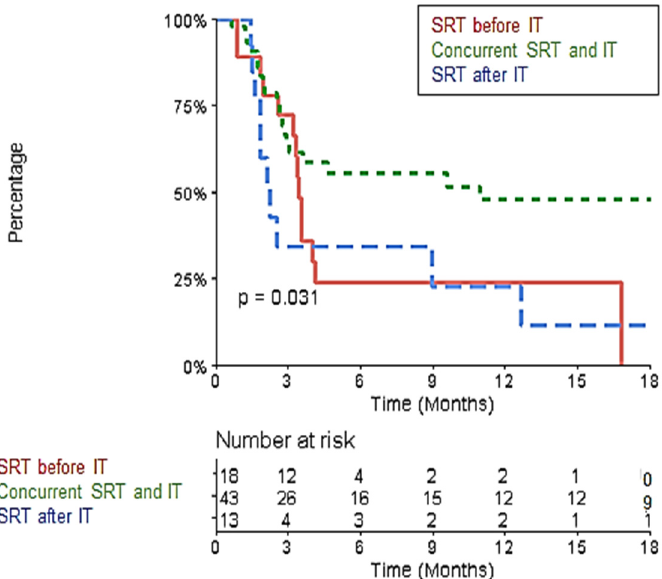
Figure 5. Kaplan–Meier Curve of Local Progression-Free Interval comparing the ‘concurrent SRT and IT,’ ‘SRT before IT,’ and ‘SRT after IT’ groups after excluding the “Durvalumab” group.